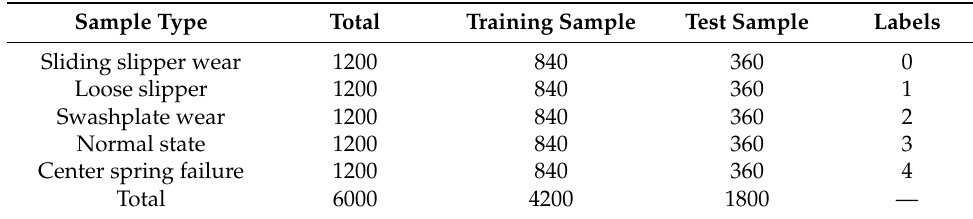
Table 1. Signal samples and